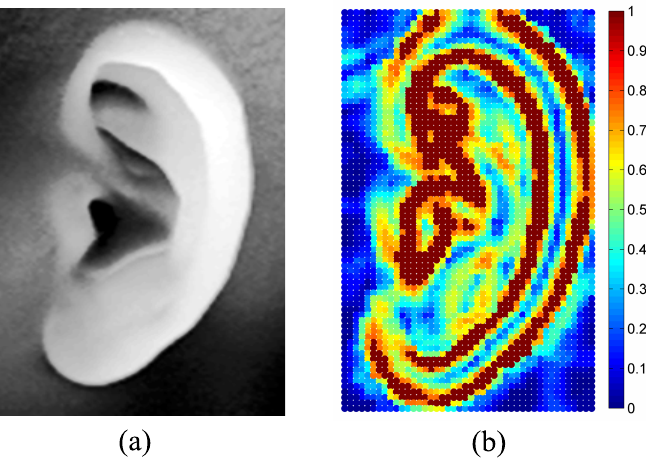
Figure 3. The LSV values of human ear: ( a ) The range image; ( b ) The LSV value map.